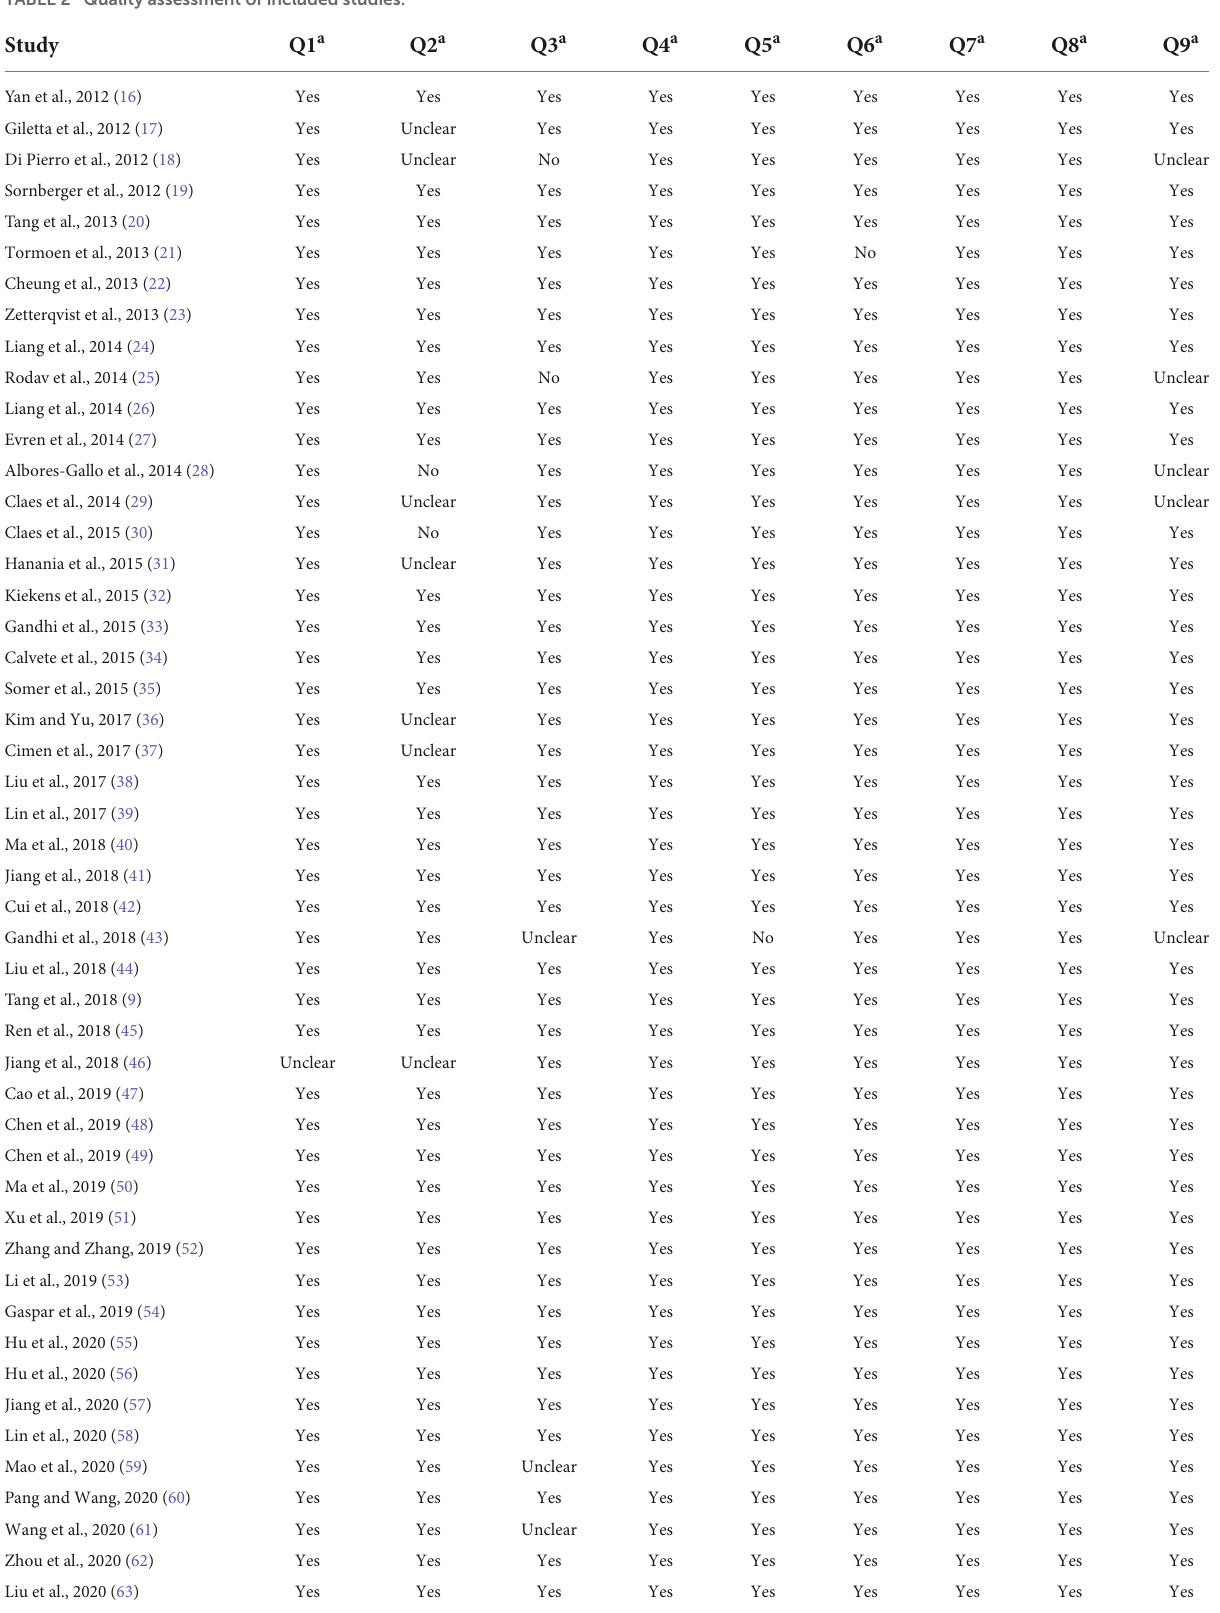
TABLE 2 Quality assessment of included